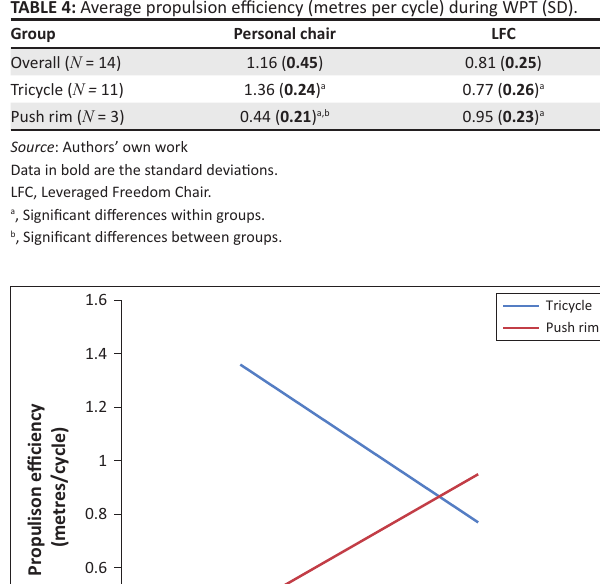
TABLE 3: Wheeled mobility results reflecting means and standard deviations ( N = 14). Group